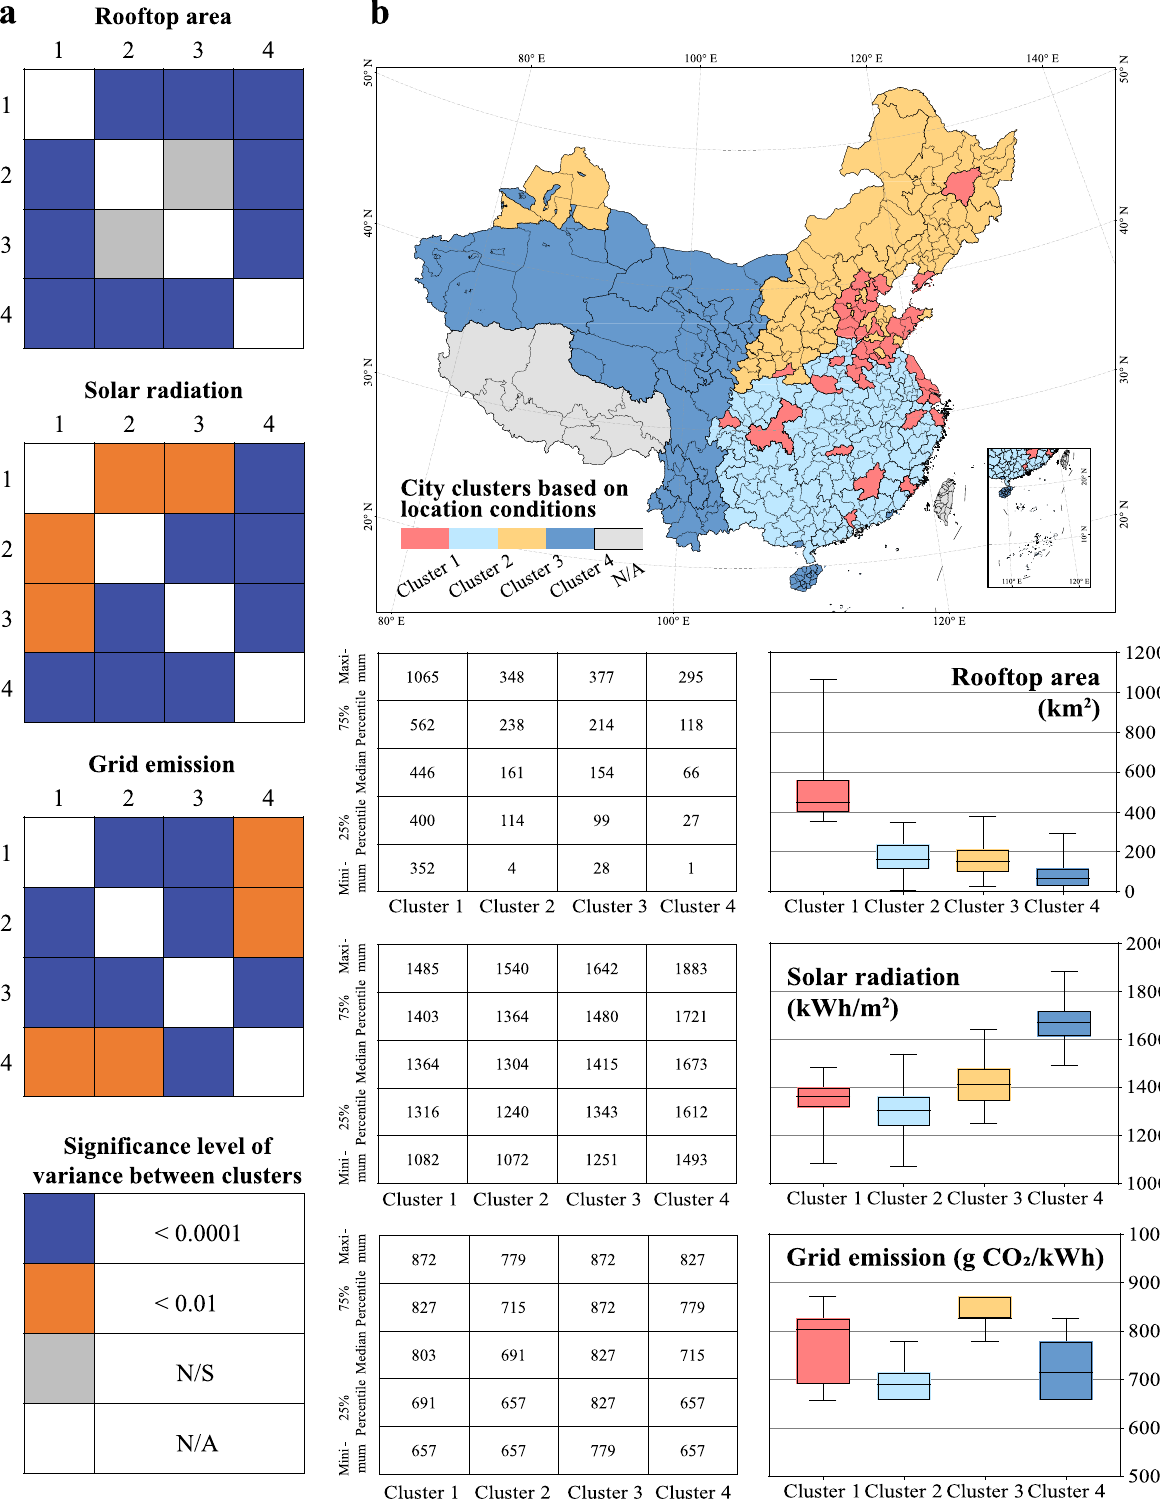
Fig. 4 | Clustering analysis of cities, based on location conditions that deter- mine the RPV carbon mitigation potential. a K-means++ clustering was per- formed for the three types of location conditions that determine the RPV carbon mitigation potential, and the 354 cities were categorized into four clusters with statistically signi fi cant differences in rooftop area, solar radiation, and grid